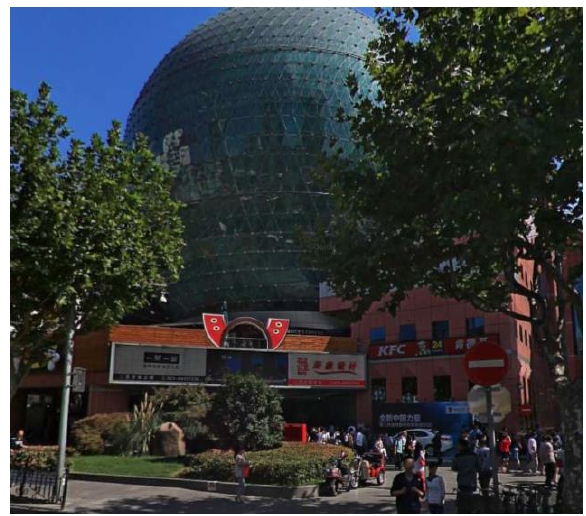
Figure 4. The overview of the Meiluocheng